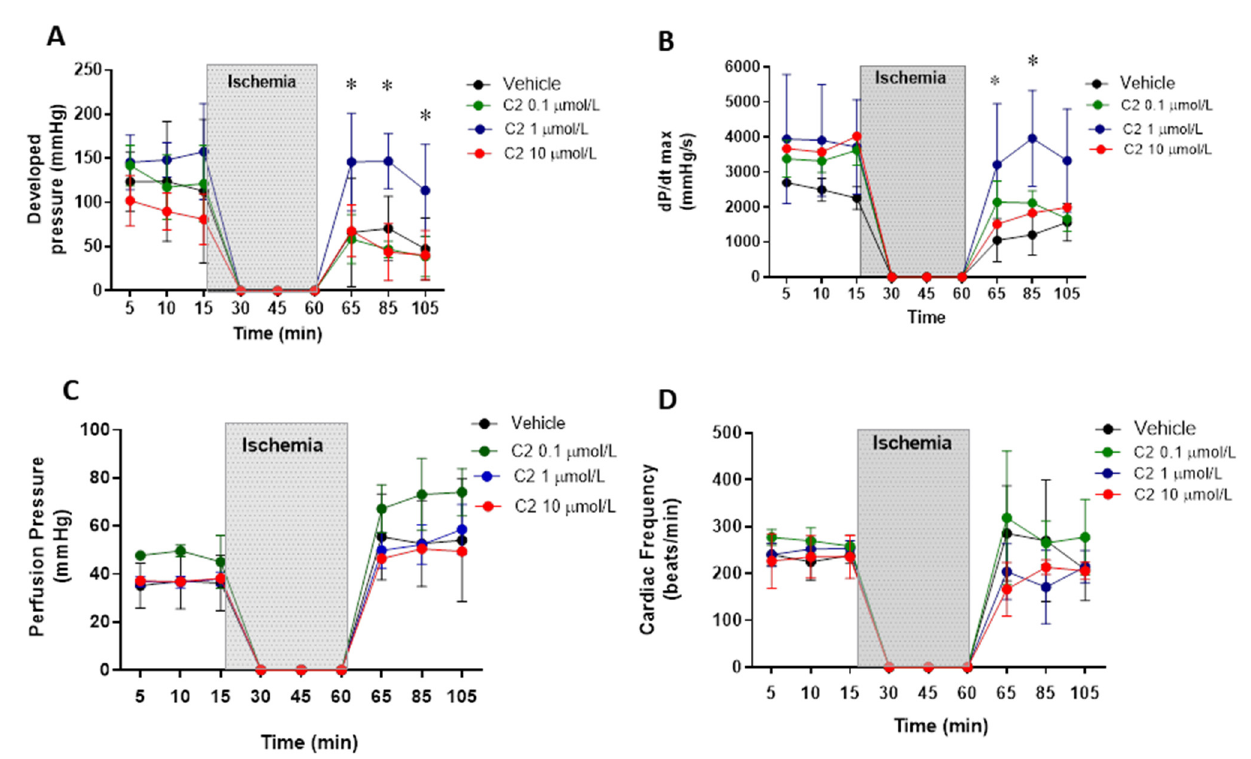
Figure 1. Impact of S-nitrosoglutathione reductase (GSNOR) inhibitor on hemodynamic parameters in a model of cardiac ischemia–reperfusion. Effect of GSNOR inhibitor (C2) at 3 different concentrations (0.1, 1 and 10 µ mol/L) and controls (vehicle) on ( A ), left ventricular developed pressure, ( B ), cardiac contractility evaluated as dP/dt max , ( C ), coronary perfusion pressure, and ( D ), cardiac frequency. The shaded area corresponds to the period of time (45 min) that the isolated heart was in ischemia by stopping the perfusion. Asterisk (*) indicates p < 0.05, compared to the other groups, by 2-way ANOVA with multiple comparisons followed by Newman Keules as post-hoc analysis. n = 5 in each group.